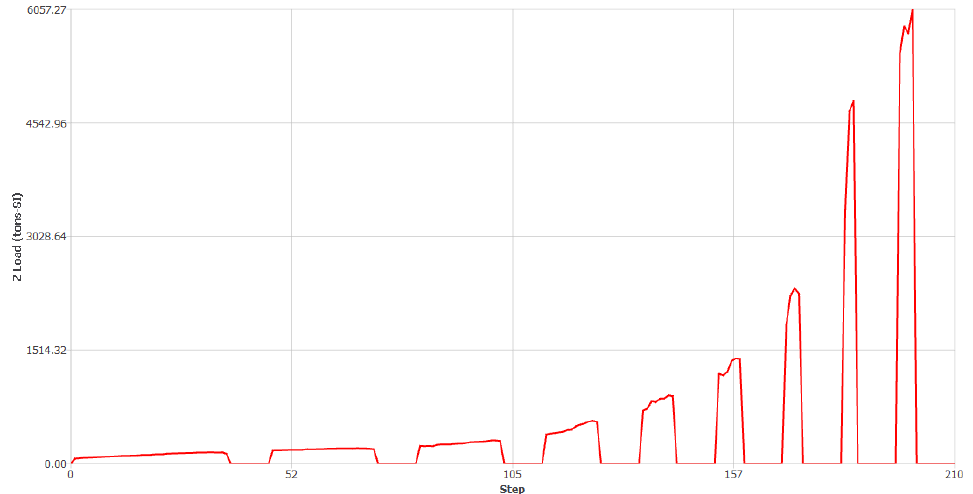
Figure 19. Plotted Load vs. Step for Near-net pinion shaft with teeth and multilevel head.